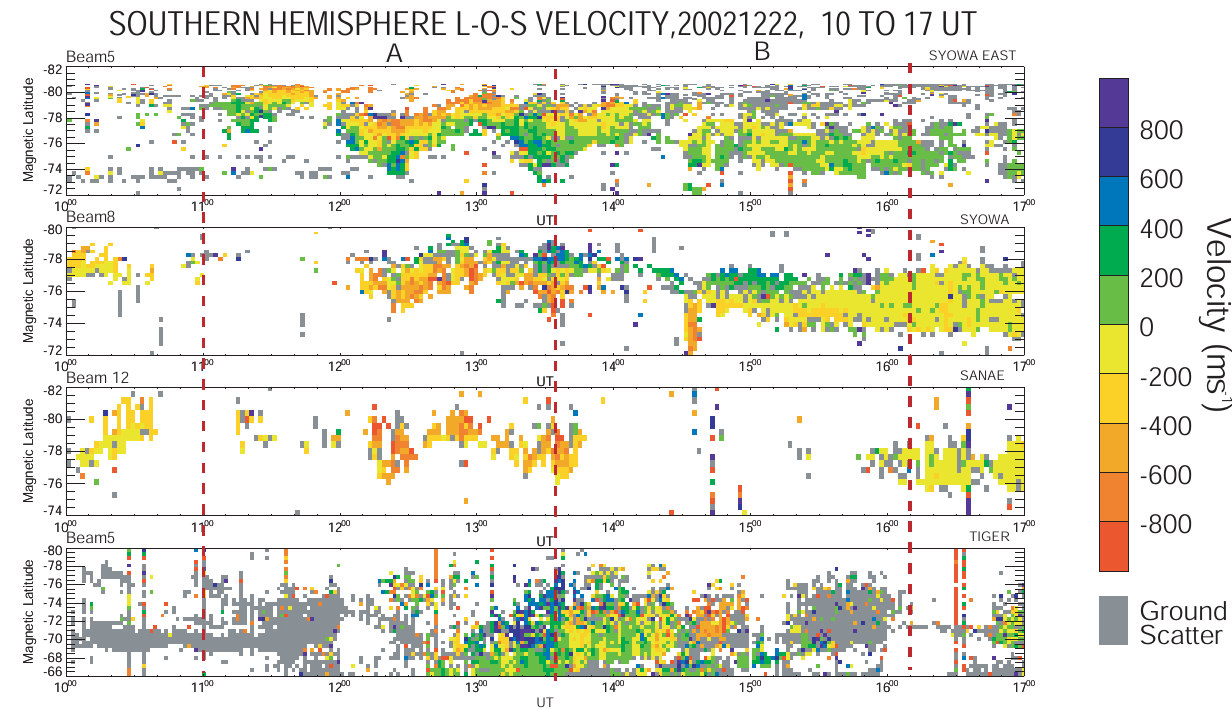
Fig. 4. L-o-s velocities are shown from four of the Southern Hemisphere radars from 10:00 to 17:00 UT; Syowa East (beam 5), Syowa (beam 8), Sanae (beam 12) and Tiger (beam 5). Time intervals A and B are indicated by the red vertical dashed